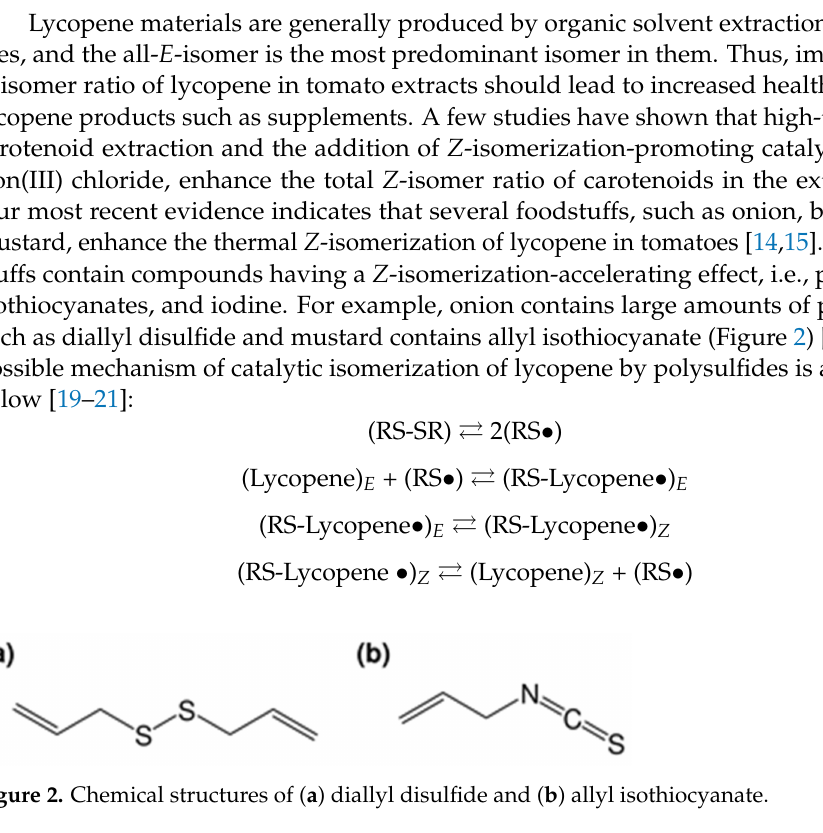
Figure 1. Chemical structures of ( a ) (all- E )-lycopene and ( b ) lycopene Z -isomer (5 Z ,9 Z -isomer).